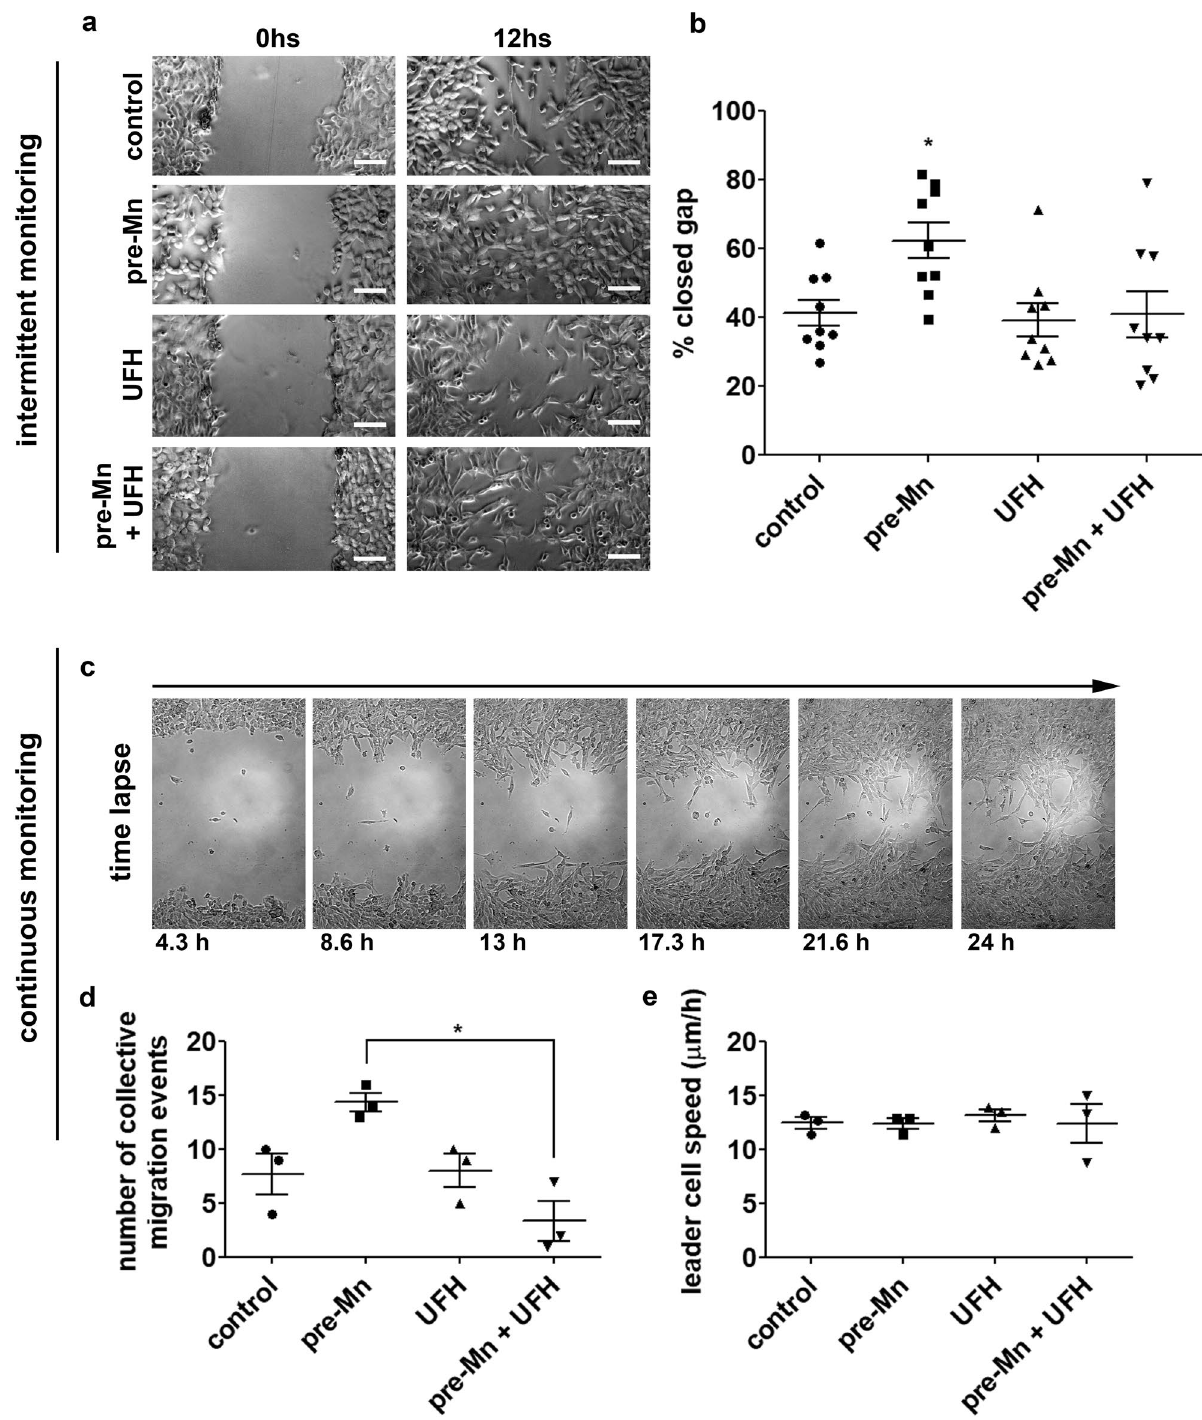
Figure 4. Manganese modulates tumor cell migration pattern. LLC cells migration pattern was evaluated in wound healing assays by intermittent ( a , b ) and continuous ( c – e ) monitoring. Cells were ( a ) imaged and ( b ) total migrated distance was quantified. N = 9. ( c ) Time lapse images—example from a Mn-pretreated cells migration video—were also acquired and compilated into videos for ( d ) collective migration quantification. ( e ) Single-cell speed was calculated from videos. N = 3. UFH (bovine unfractionated heparin—0.1 ng/mL); pre-Mn